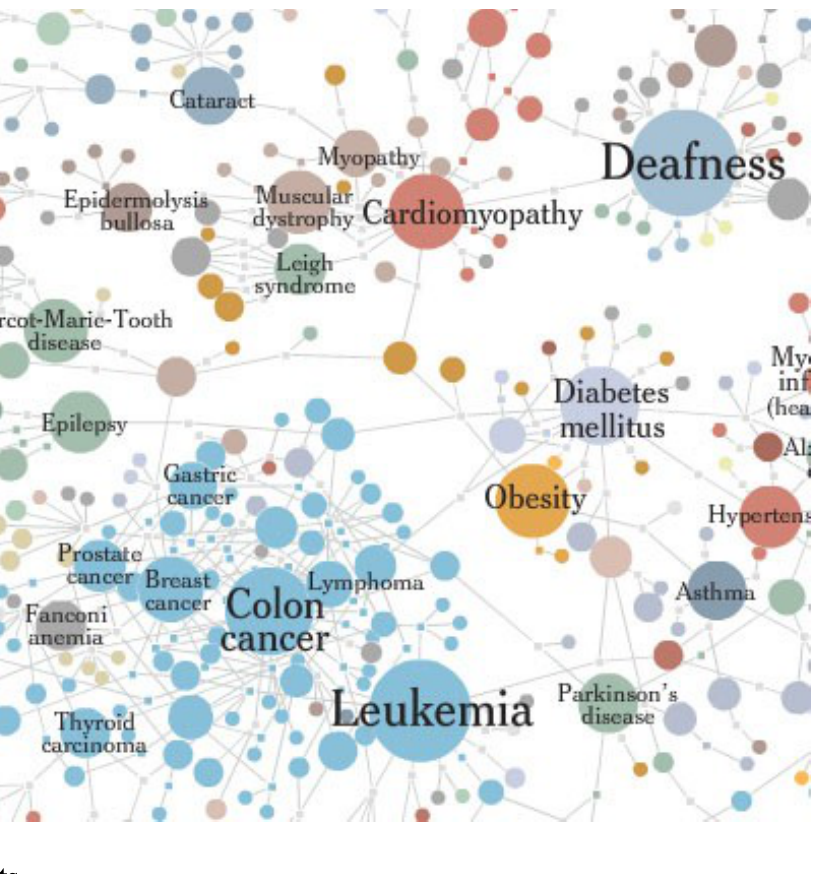
Figure 14. Disease network relationships between cardiomyopathy and muscular